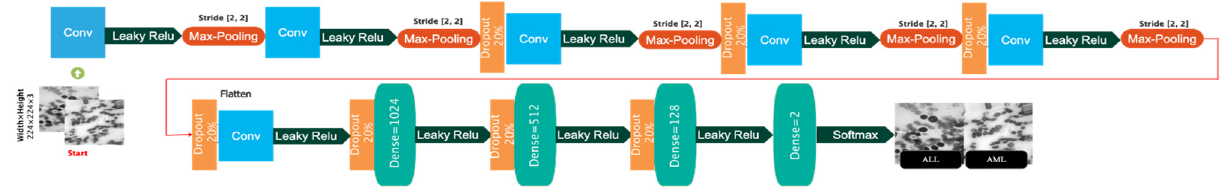
Figure 5. The architectural details of the customized CNN model.